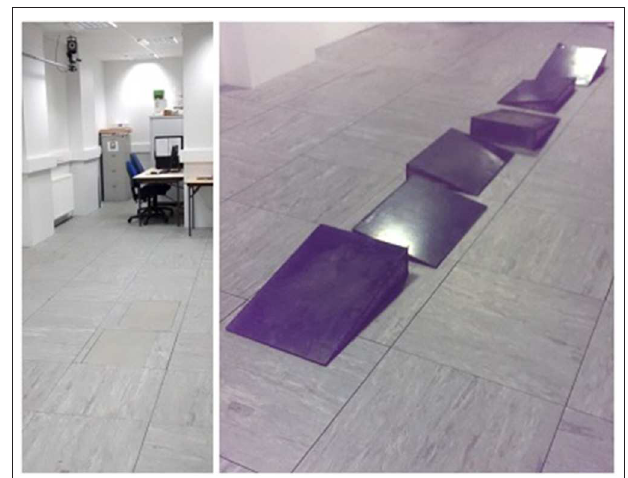
FIGURE 1 | Level-Ground (left) and Uneven Terrain (right)